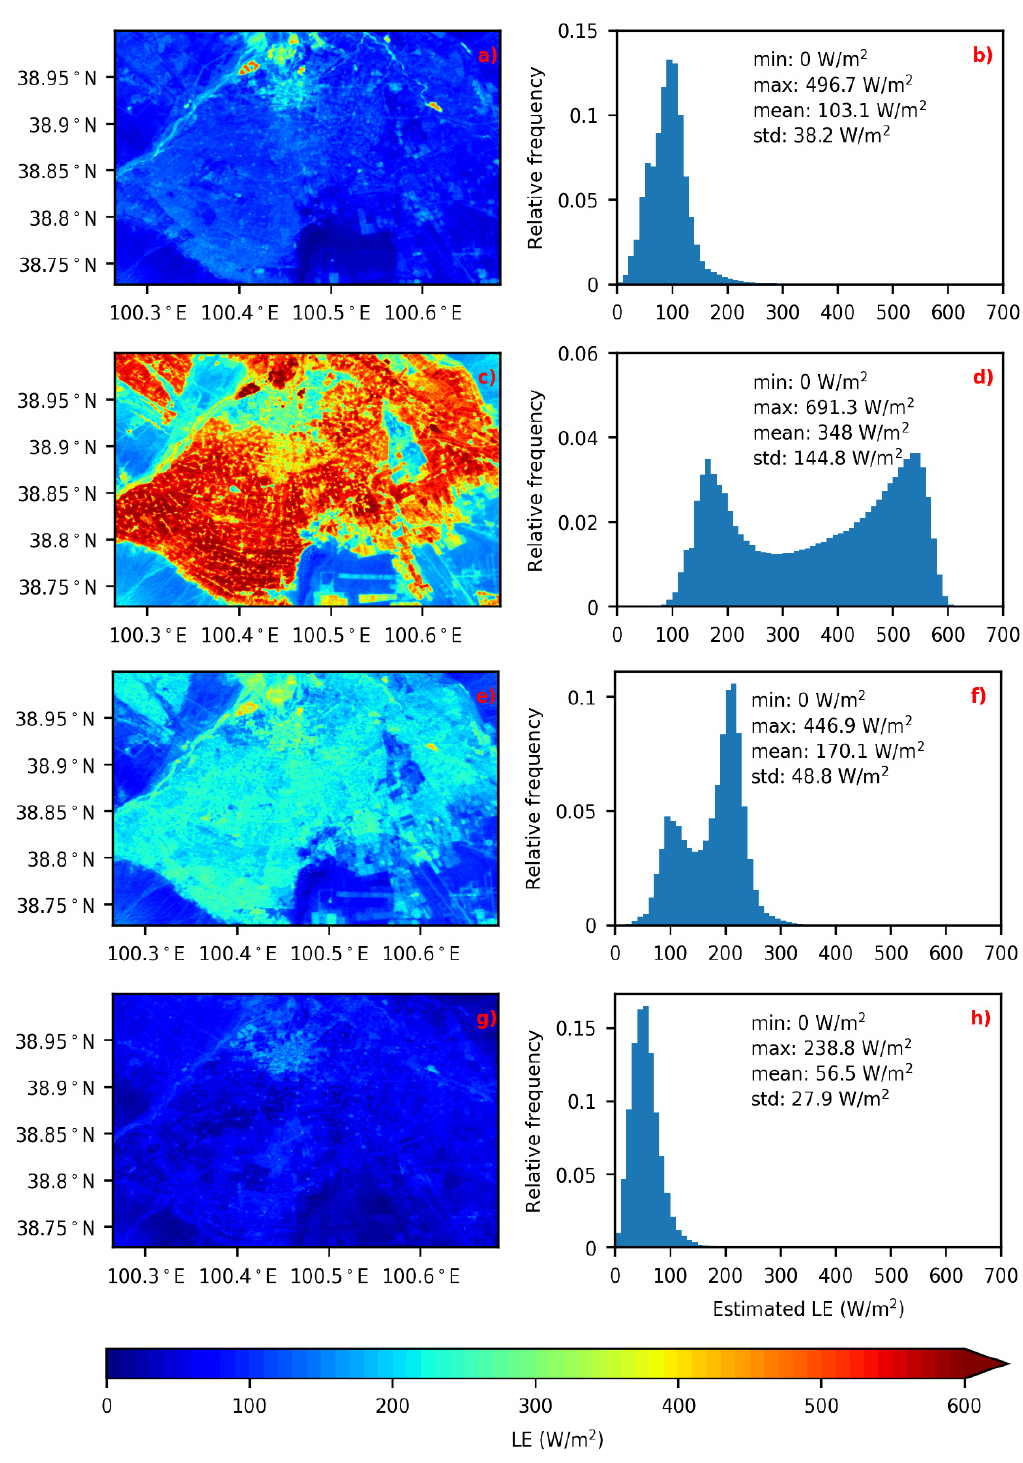
Figure 5. Spatial distributions of LE estimates from the WAPT model in four seasons. The results were averaged over the years 2013–2018. The left panels are the maps of LE estimates, respectively, for spring (from March to May) ( a ), summer (from June to August) ( c ), autumn (from September to November) ( e ), and winter (from December to February) ( g ). The right panels are the corresponding pixel distributions of LE estimates, spring ( b ), summer ( d ), autumn ( f ), and winter ( h ), respectively. Spatial minimum (min), maximum (max), mean, and standard deviation (std) of the LE estimates are given.